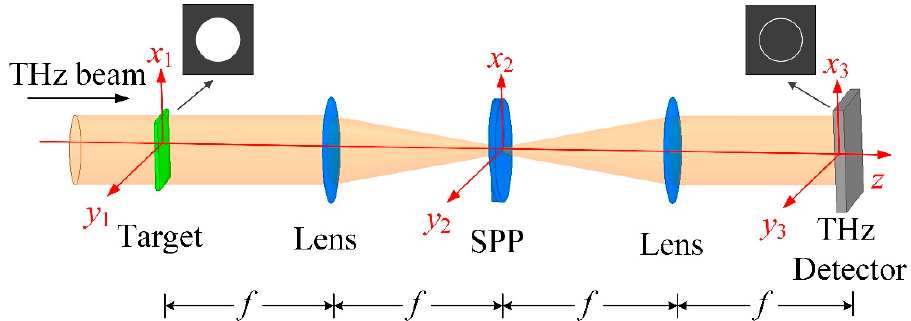
Figure 1. Schematic of the terahertz (THz) spiral spatial filtering (SSF) imaging system. A collimated THz beam illustrates the target, then it enters into the 4 f imaging system. After passing through the spiral phase plate (SPP) in the Fourier plane, the filtered THz beam is received by the THz detector finally.